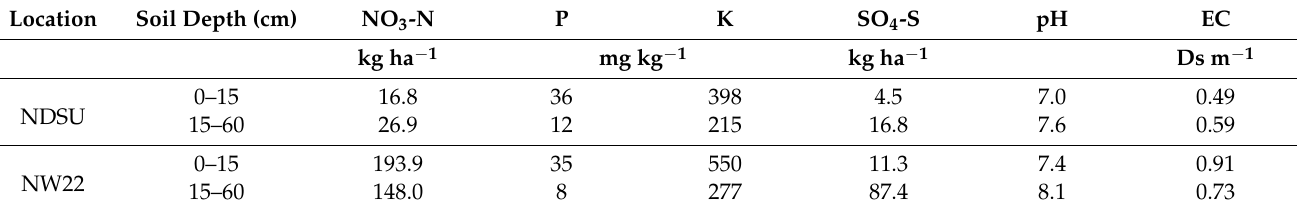
Table 2. Baseline early season (1 June 2020) soil tests at 0–15 cm and 15–60 cm for nitrogen (NO 3 -N), phosphorus (P), potassium (K), sulfur (SO 4 -S), pH and electrical conductivity (EC) included six randomly pooled soil samples taken at each location (NDSU and NW22).